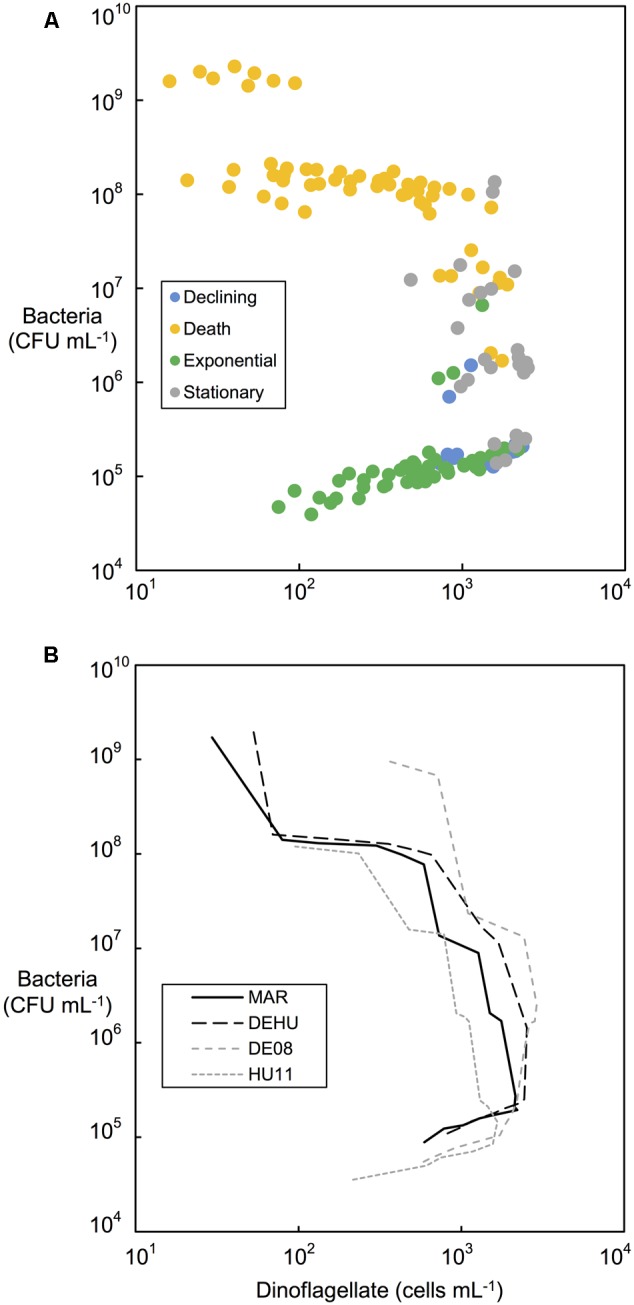
Bacterial and dinoflagellate cell concentrations (cells mL-1) during different phases of dinoflagellate culture growth. (A) All replicate controlled associate community cultures categorized according to dinoflagellate growth phases indicated by colored bars in Figures 2, 3. (B) Comparison of mean bacterial and dinoflagellate concentrations from replicate cultures (n = 2) of three-way combination (MAR) compared to a mixed community (DEHU) and each parental non-axenic culture (GCDE08 and GCHU11). See Table 1 for culture codes and additional detail.